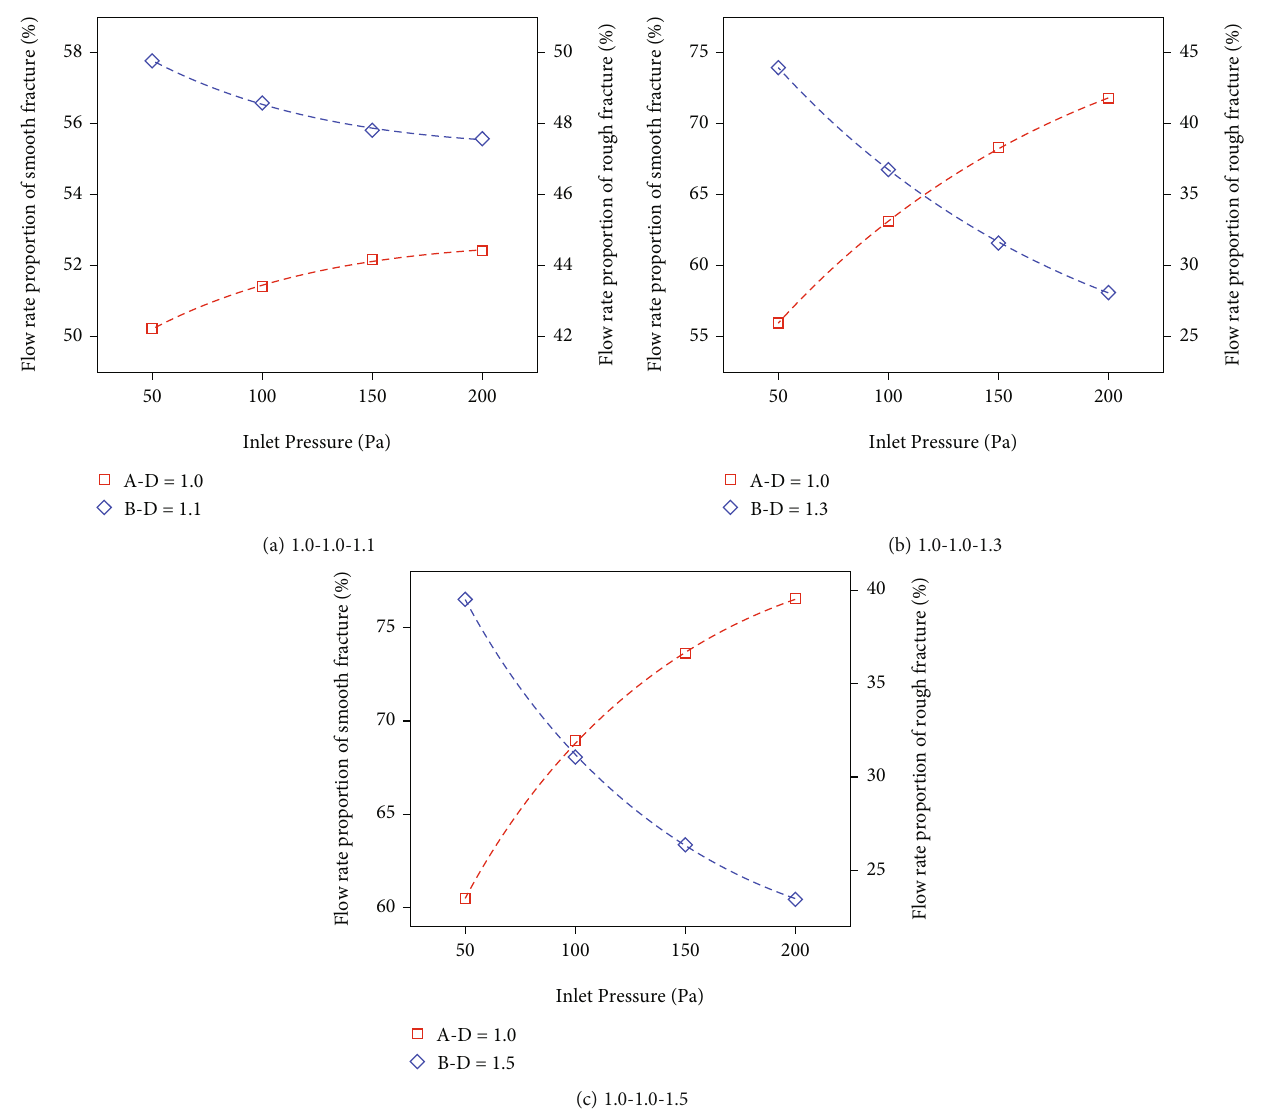
Figure 9: Evolution of outlet fl ow rate proportion with inlet